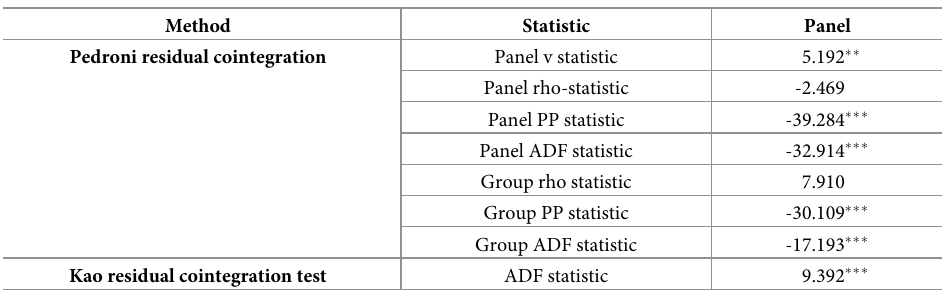
Table 4. Panel cointegration